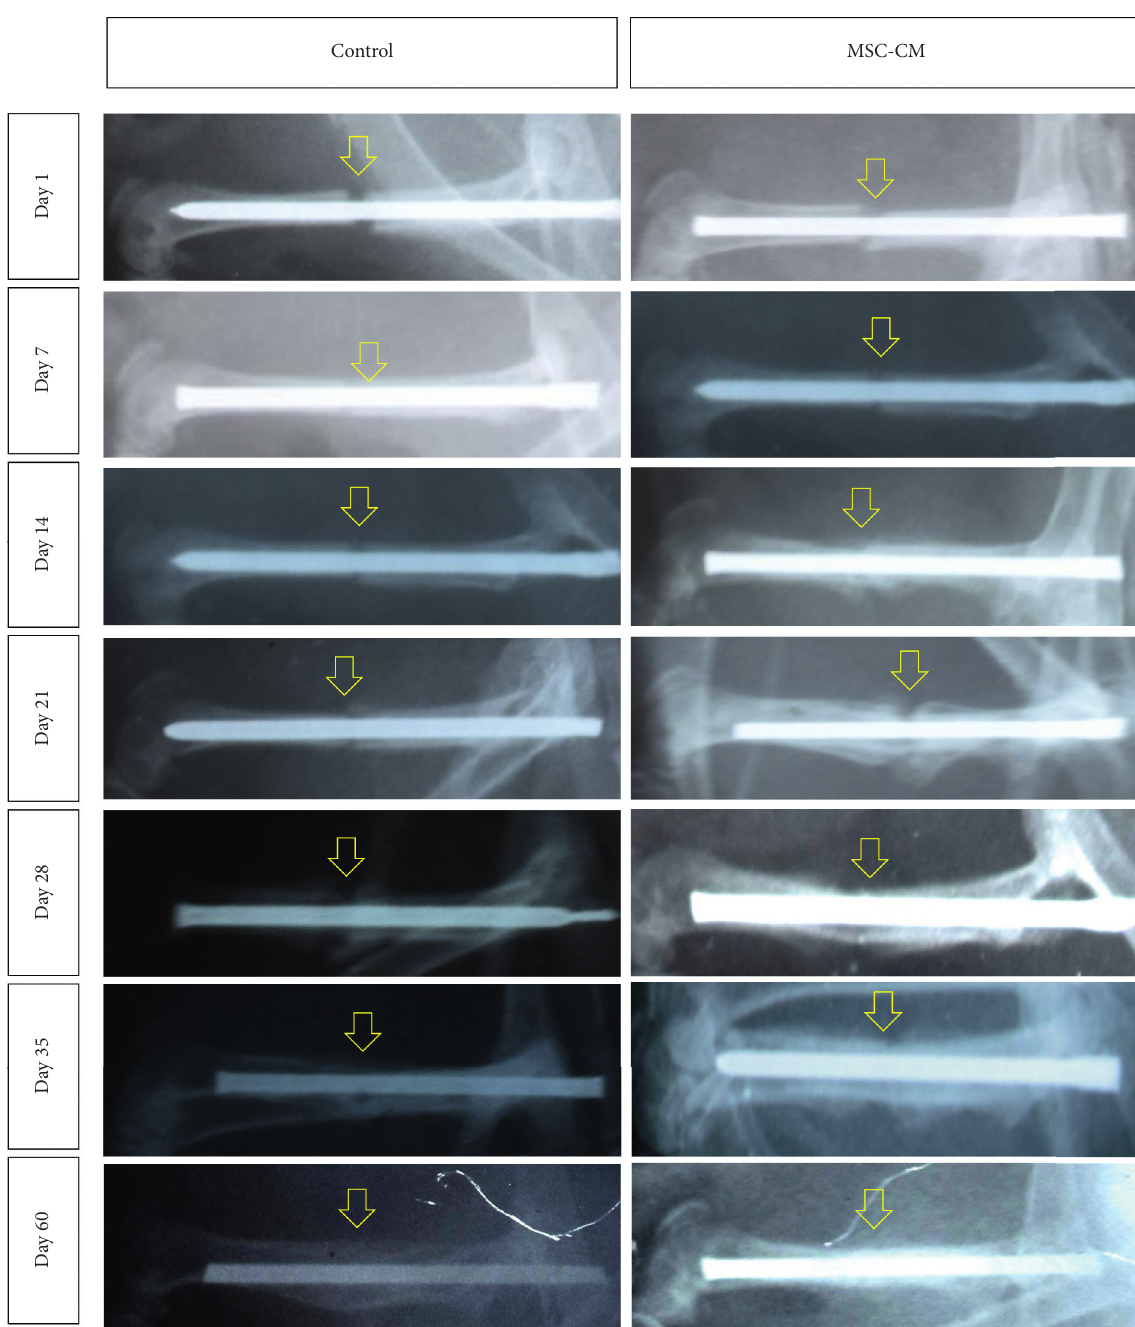
Figure 1: Radiographic images of rats femur bone in control and MSC-CM groups on days 1–60 after surgery. The yellow arrow indicates the gap fracture area of the bone. The callus formed around the gap fracture area is more radiolucent than the compact